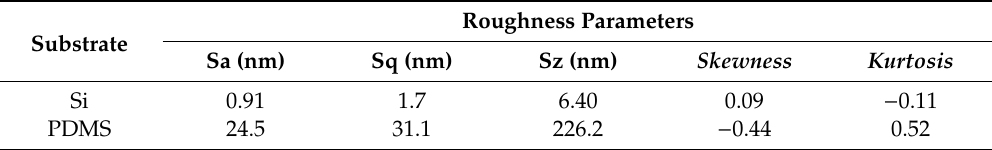
Figure 4. AFM topographic images of N1 surface deposited onto: ( a ), ( b ) PDMS, and ( c ) Si. ( d ) SEM micrograph of double scale wrinkles of N1. Table 2. Roughness parameters, determined by AFM, of N1 thin film deposited onto PDMS and Si substrates.